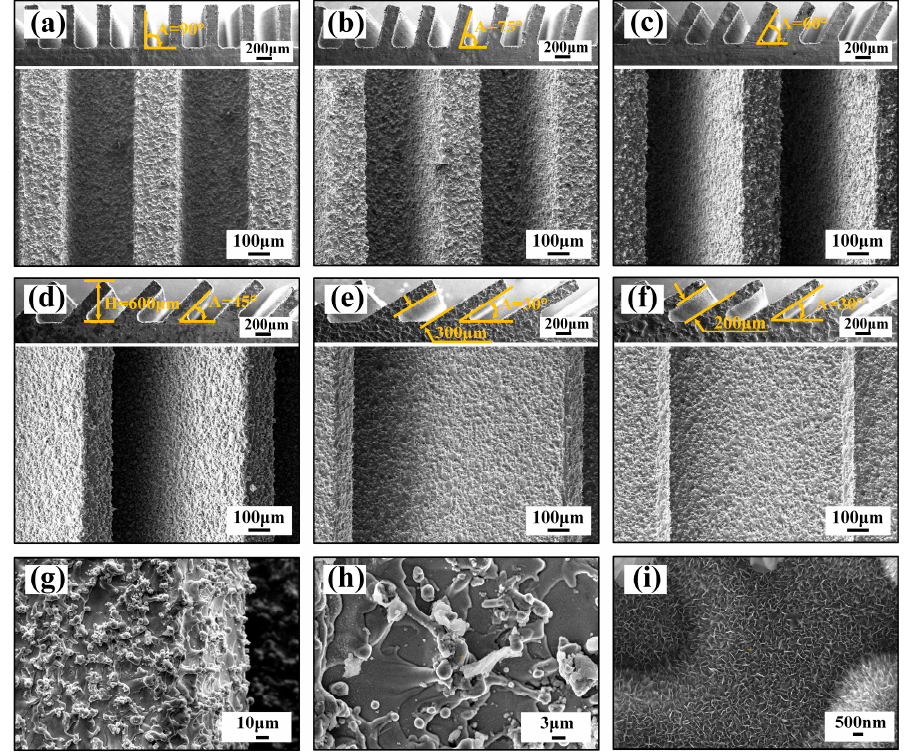
Figure 2. SEM images of di ff erent shapes of titanium alloy surface: ( a – e ) L = 300 µ m, A = 90 ◦ , 75 ◦ , 60 ◦ , 50 ◦ , and 30 ◦ groove structure surface; ( f ) L = 200 µ m, A = 30 ◦ groove structure surface; ( g ) micron structure formed by WEDM processing; ( h , i ) nanostructure formed by AH reaction.